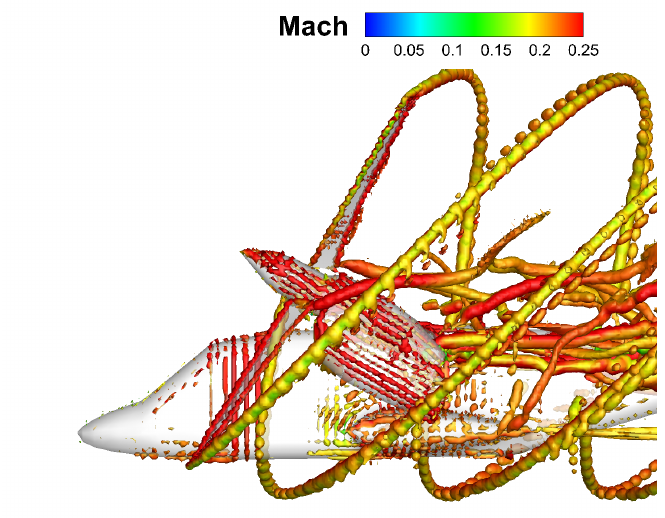
Figure 22. Instantaneous flow field computed by DUST in conversion flight condition at ψ = 270 ◦ , θ N = 30 ◦ , V ∞ = 140 kts, Ω = 589 RPM; iso-surface of Q-Criterion.